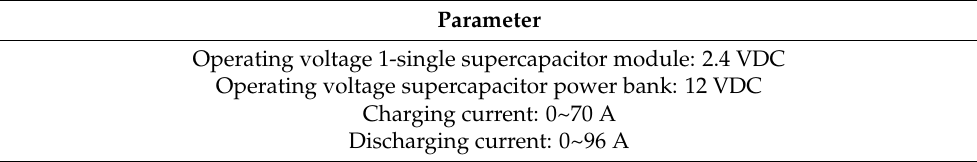
Table 3. Supercapacitor power bank system